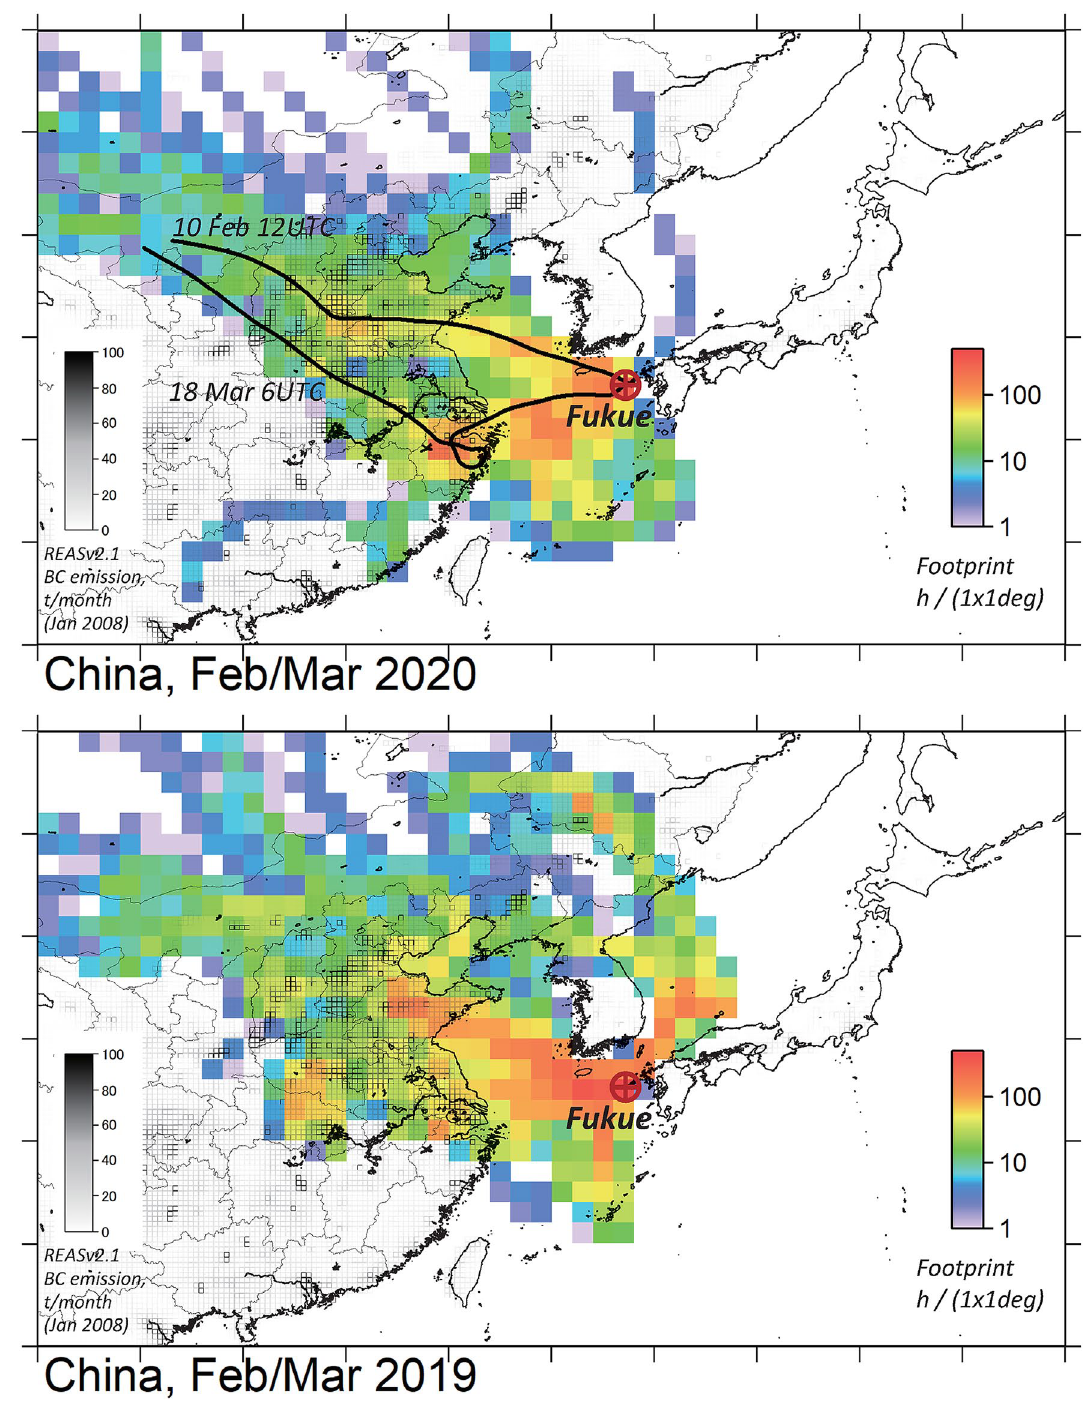
Figure 1. Location of Fukue atmospheric environment observatory and footprint density distribution during (top) Feb–Mar 2020 and (bottom) Feb–Mar 2019. For 2020, two backward trajectories are also depicted. BC emission distribution from REAS version 2.1 16 is indicated with squares with gray-scaled